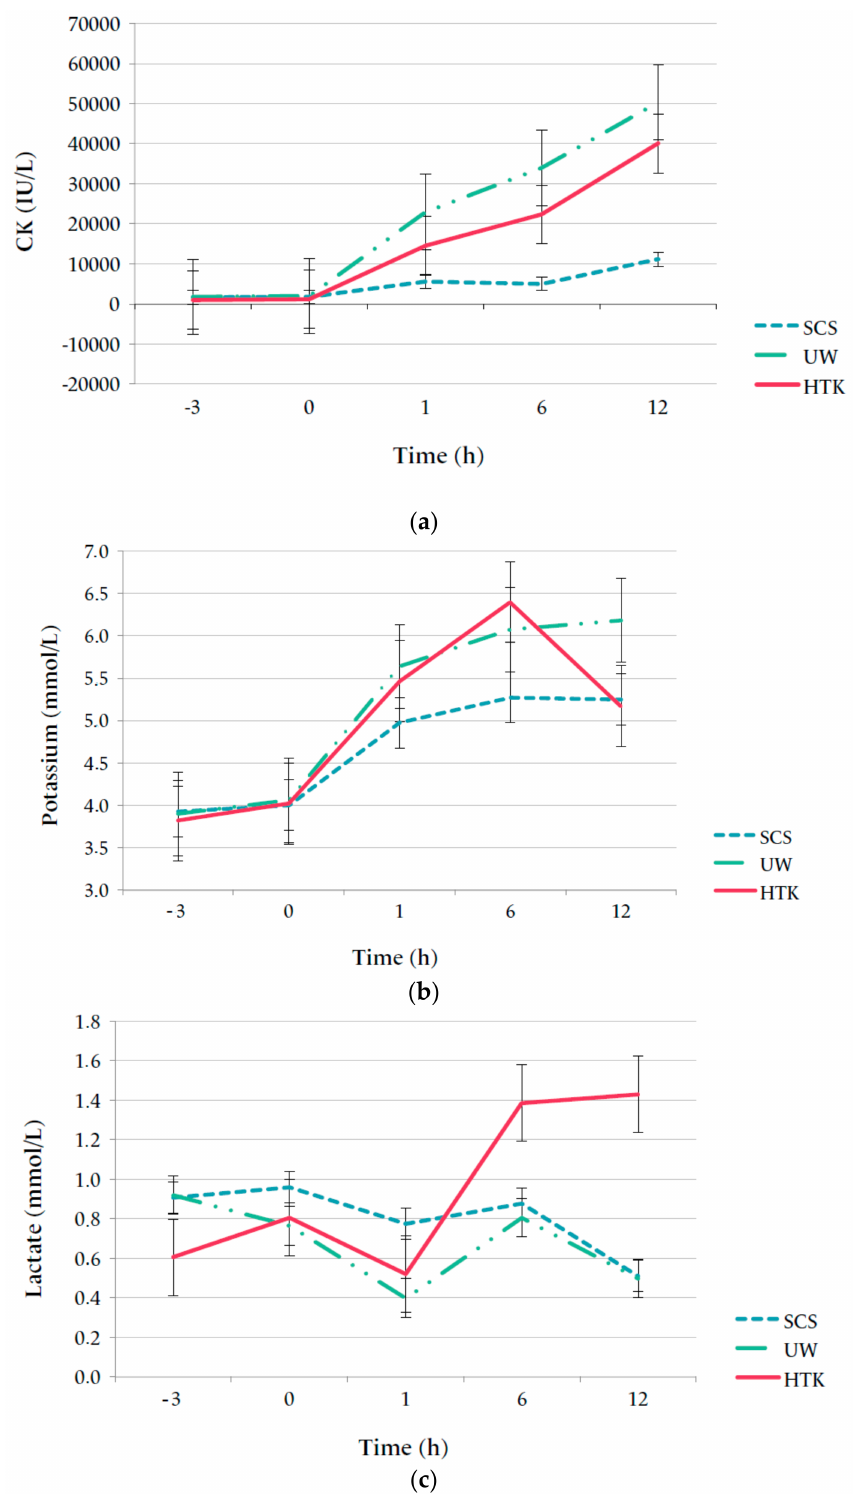
Figure 4. Mean CK ( a ), potassium ( b ) and lactate ( c ) per pig. Arterial measurements were taken dur- ing flap retrieval and after flap replantation. Porcine reference values: CK 153–5427 U/L, potassium 3.7–6.1 mmol/L, lactate unknown